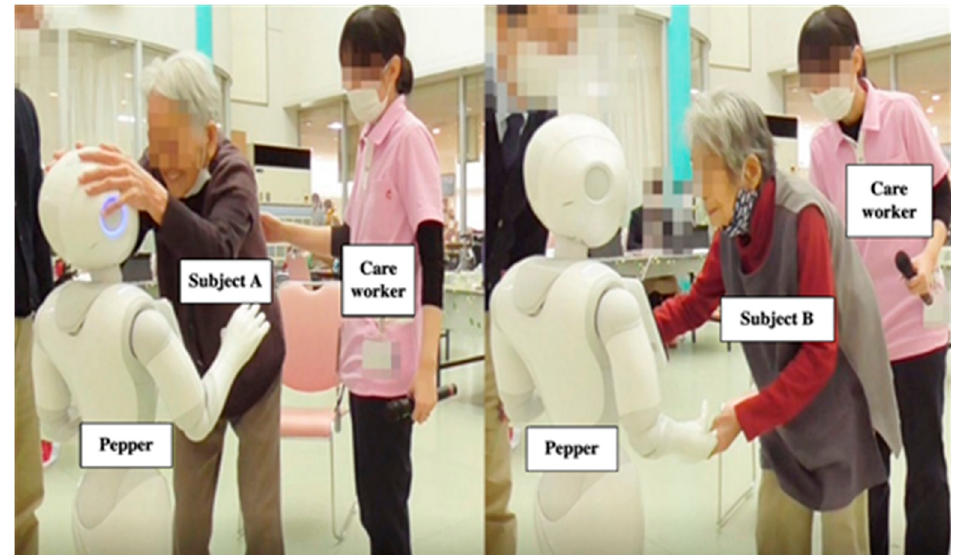
Figure 5. Subjects A and B stroked Pepper’s head and repeatedly thanked Pepper, saying, “Thank you.”